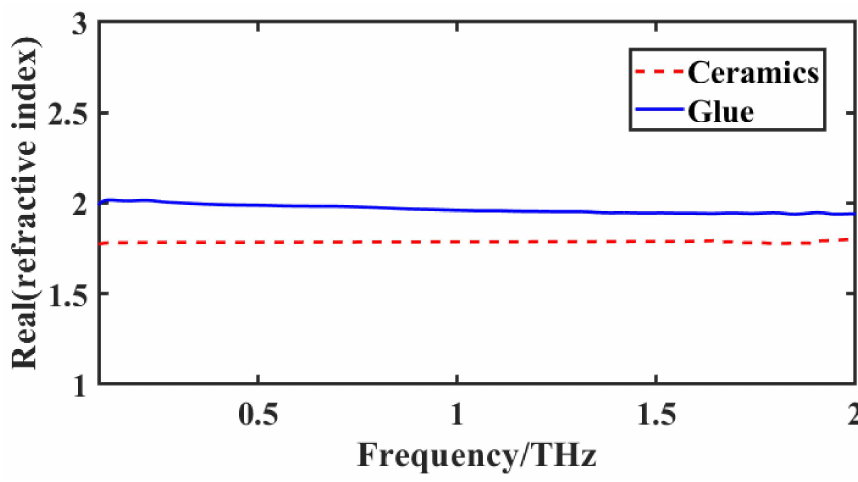
Figure 5. The real part of the refractive index for ceramics and glue.